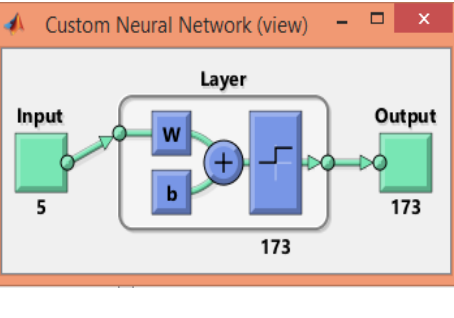
Figure 10. Custom neural